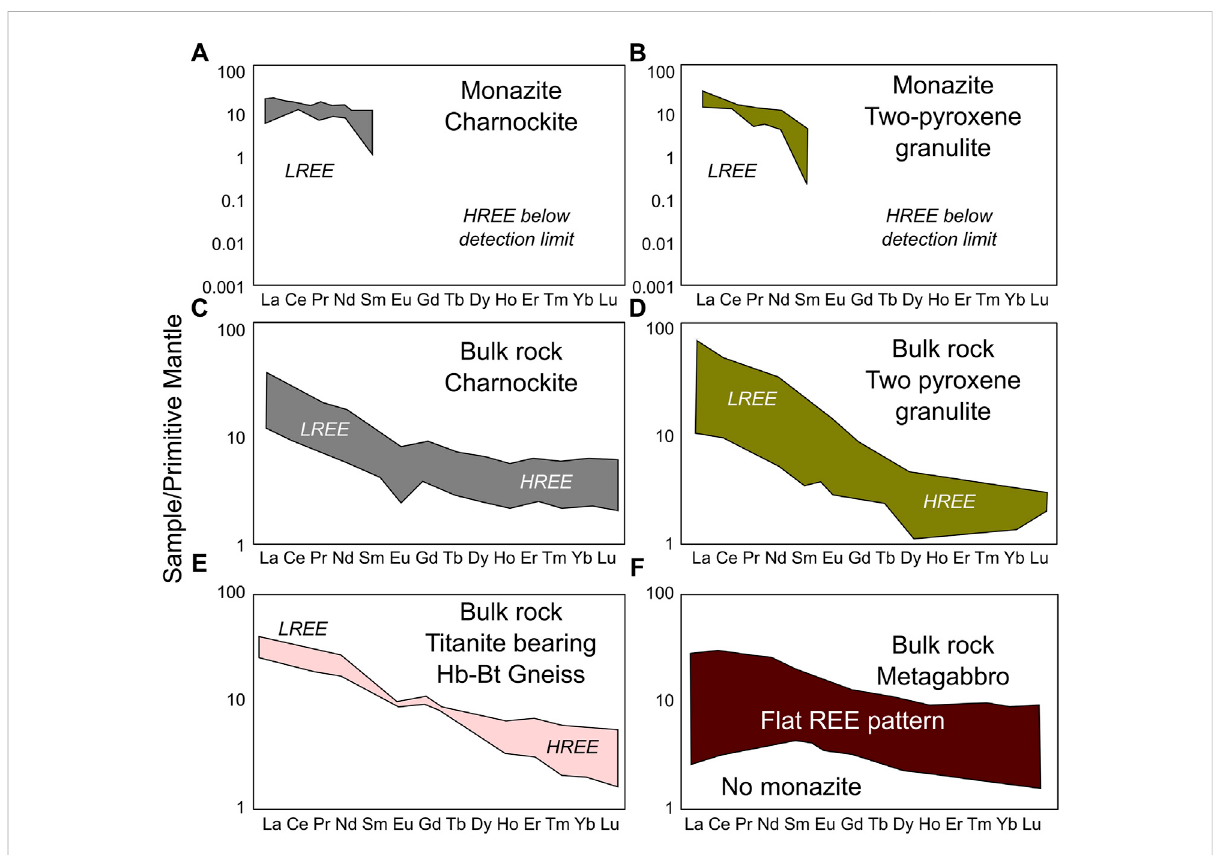
FIGURE 9 Primitive mantle-normalized REE patterns for samples from Nilgiri Block. Primitive mantle values from McDonough et al. (1991). (A) REE pattern of monazite blebs present on apatite grains present in charnockite samples. (B) REE pattern of monazite blebs present on apatite grains present in two-pyroxene granulite samples. (C – F) Since apatite REE composition depend on whole-rock REE, we compare apatite REE patterns with whole- rock REE patterns for different rock types from Nilgiri Block [data taken from Samuel et al. (2014) and Raith et al. (1999); Supplementary Table